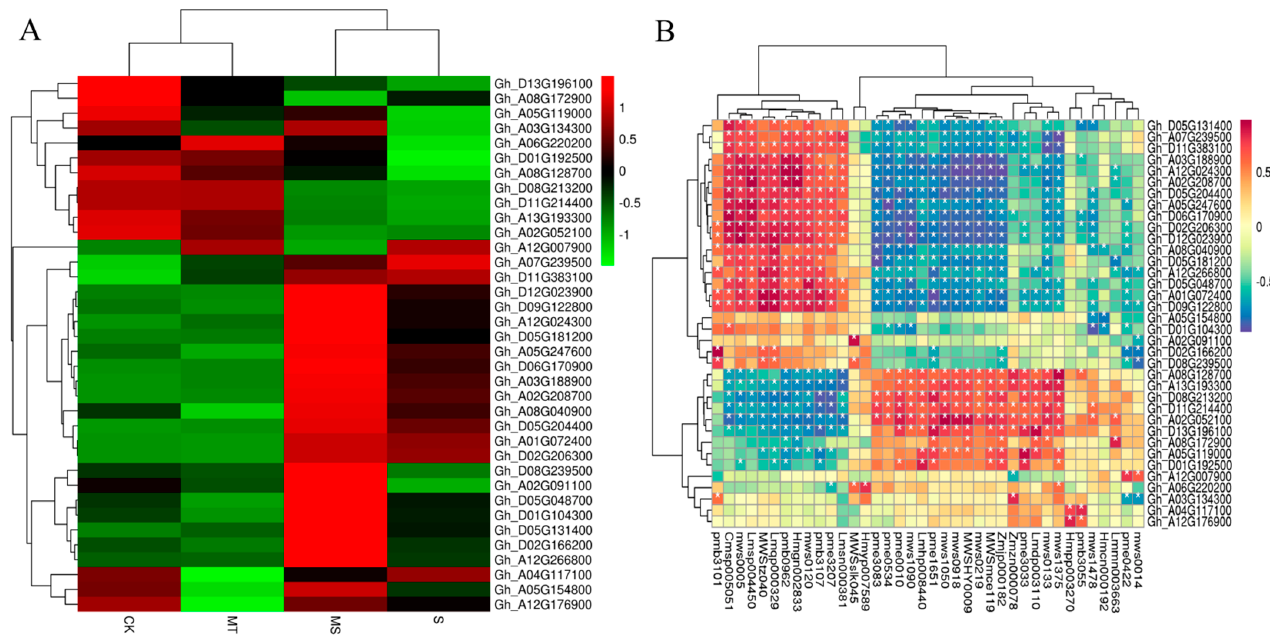
Figure 10. Correlation analysis of target gene expression levels in cotton seedling roots under control, salt, melatonin and combined salt and melatonin treatments. ( A ) Heat map of target genes under different treatments. ( B ) Correlation analysis diagram of target genes and metabolites.